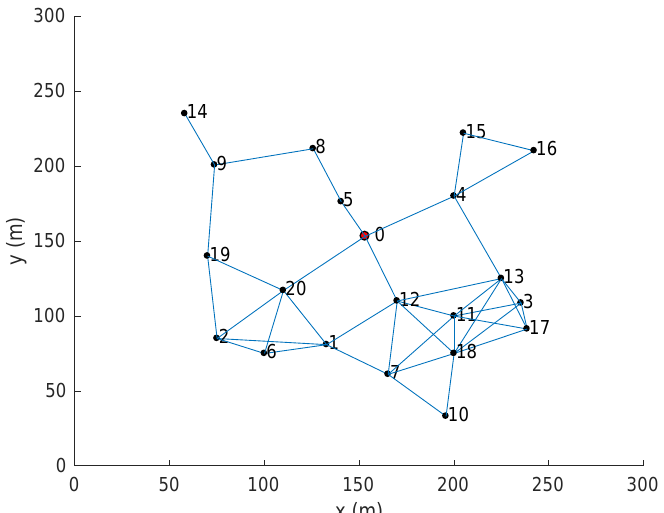
Figure 9. Network topology of one host node and 20 edge devices over 300 m × 300 m, located in a relative 2D Cartesian coordinate for simulation experiments, showing wireless links with packet reception rate ( PRR ) ≥ 0.7.